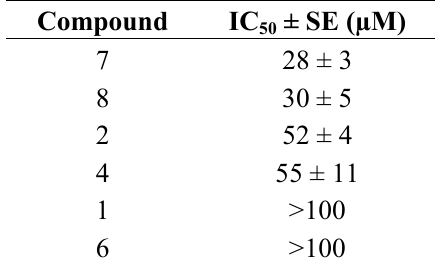
Table 2. Effects of stilbenes on B. cinerea development. Values correspond to the concentration that inhibits 50% of the mycelial growth (IC